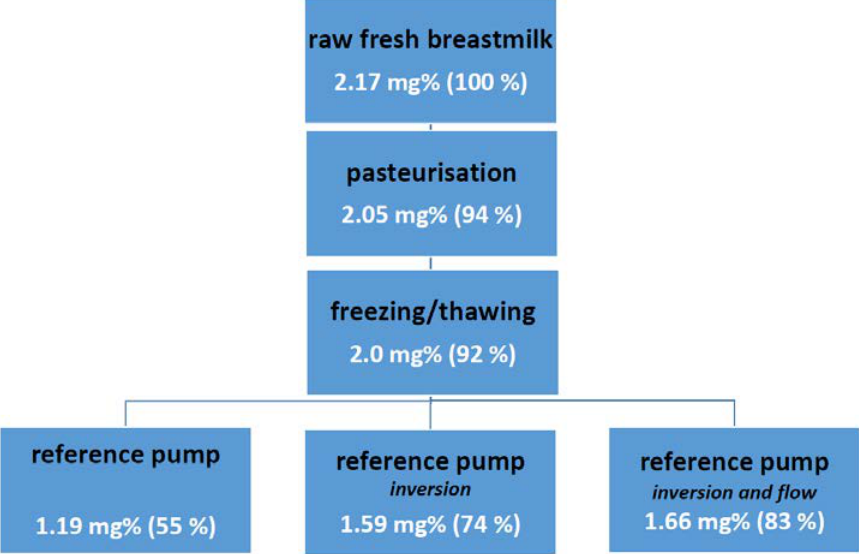
Figure 1. The progressive losses of fat content (mg%) in mother’s milk during the chain of processes commonly used in the NICU setting. The data were pooled from the publications of Vieira et al. on the impact of pasteurization and freezing/thawing and of Jarjour et al. on the impact of mixing of human milk (inversion, variable flow) during continuous infusion